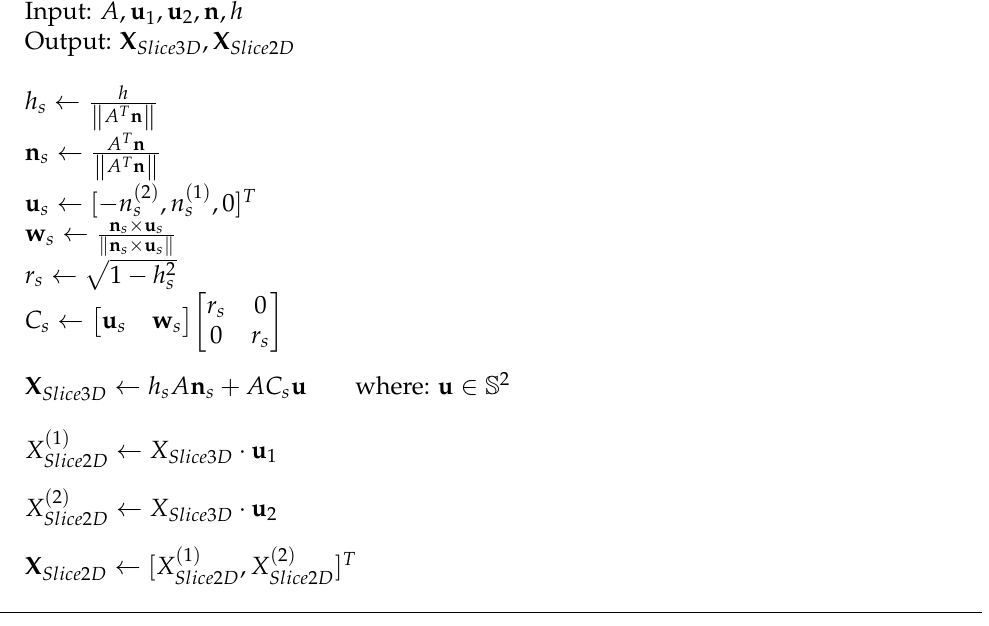
Algorithm A7 Function: Calculate elliptical slice of an ellipsoidal bound